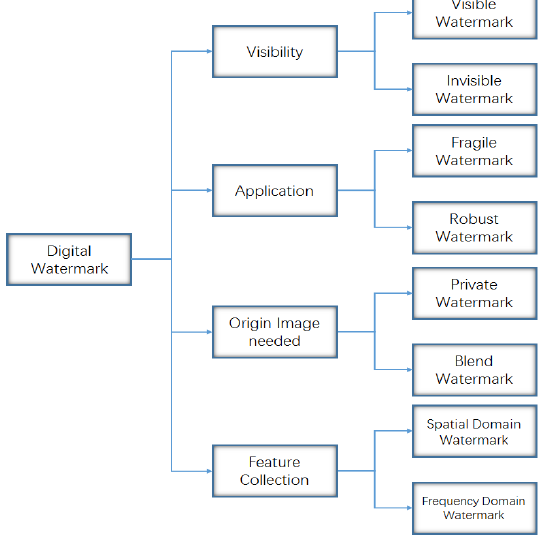
Figure 1.Classification of digital